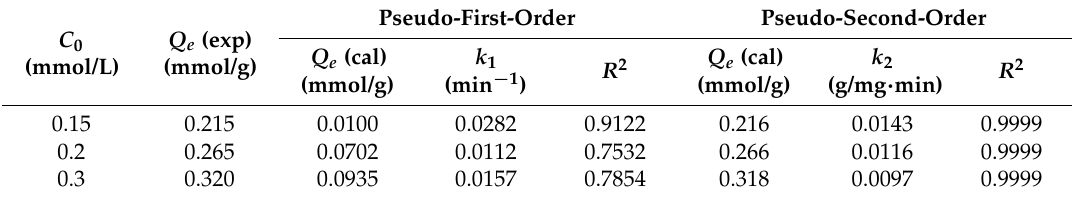
Table 4. Pseudo-first-order and pseudo-second-order kinetic parameters for CAP adsorption on AC. Pseudo-First-Order C 0 Q e (exp) (mmol/L) (mmol/g)